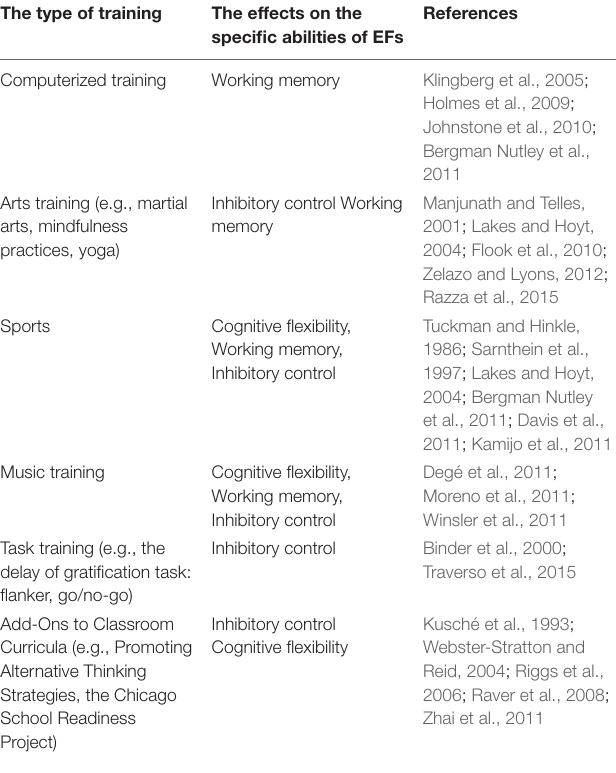
TABLE 1 | A synthetic table of